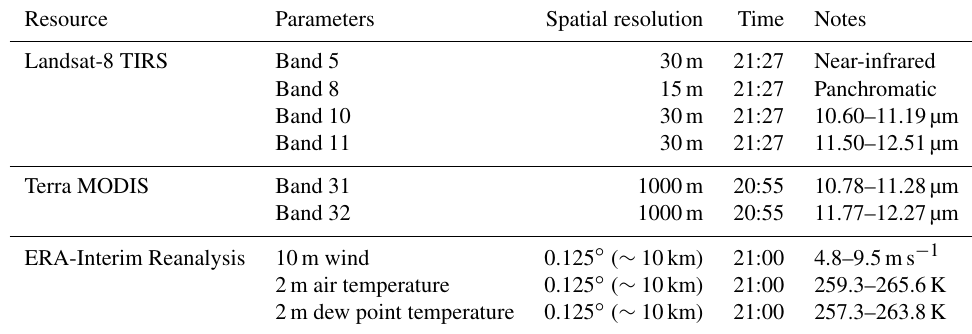
Table 1. Satellite images and other data used in this study. Resource Parameters Spatial resolution Time